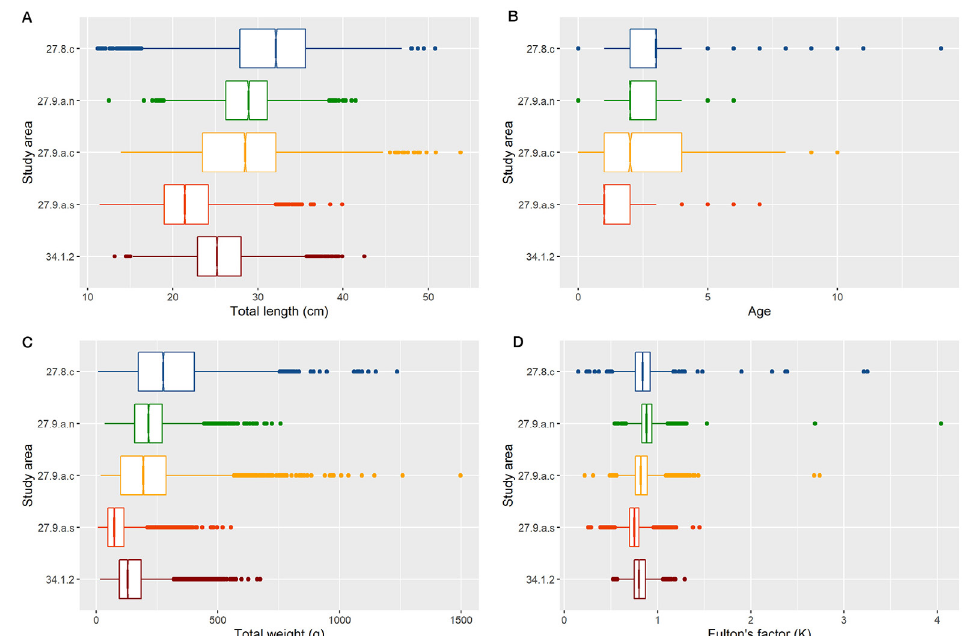
Fig. 2. – Boxplot of biological parameters by study area. A, total length; B, age (years); C, total weight and D, Fulton’s condition factor (K). Geographical study areas from south to north are 34.1.2, Canary Islands (red); 27.9.a.s, Gulf of Cadiz (orange); 27.9.a.c, W Portuguese coast (yellow); 27.9.a.n, NW Spanish coast (green); and 27.8.c, Cantabrian Sea (blue). Vertical line within the boxes represents the median, boxes represent the inter-quartile range (IQR) or distance between the first (25%) and third (75%) quartiles, the notch represents the 95% confidence interval of the median, the whiskers represent ±1.5 * IQR and dots represent the